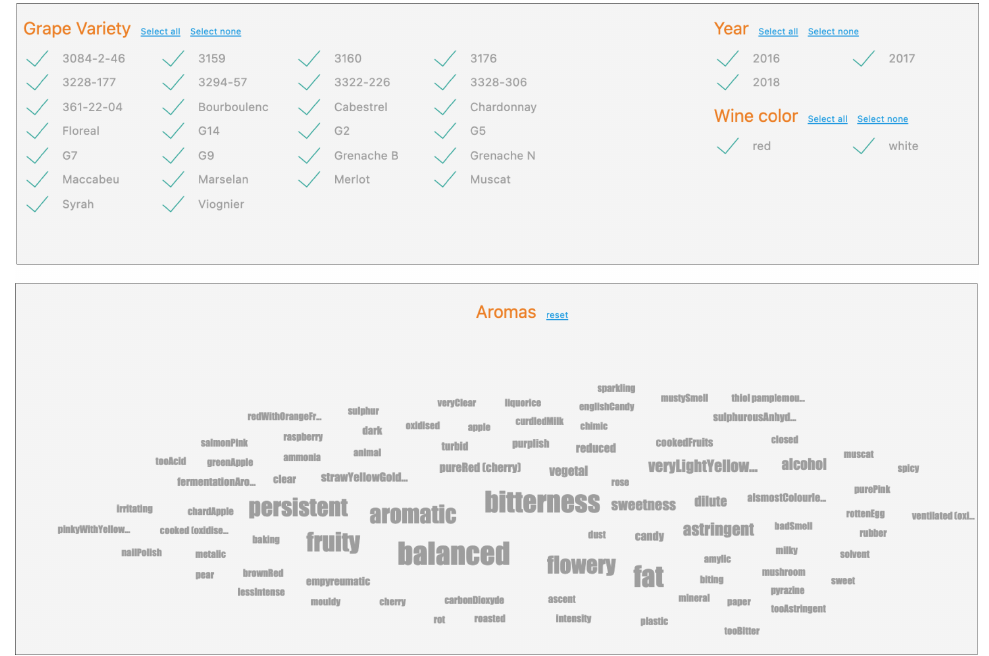
Figure 6. The filter components from Figure 4c showing that the data can be filtered by Grape Variety, Year, Wine Colour and Aromas.